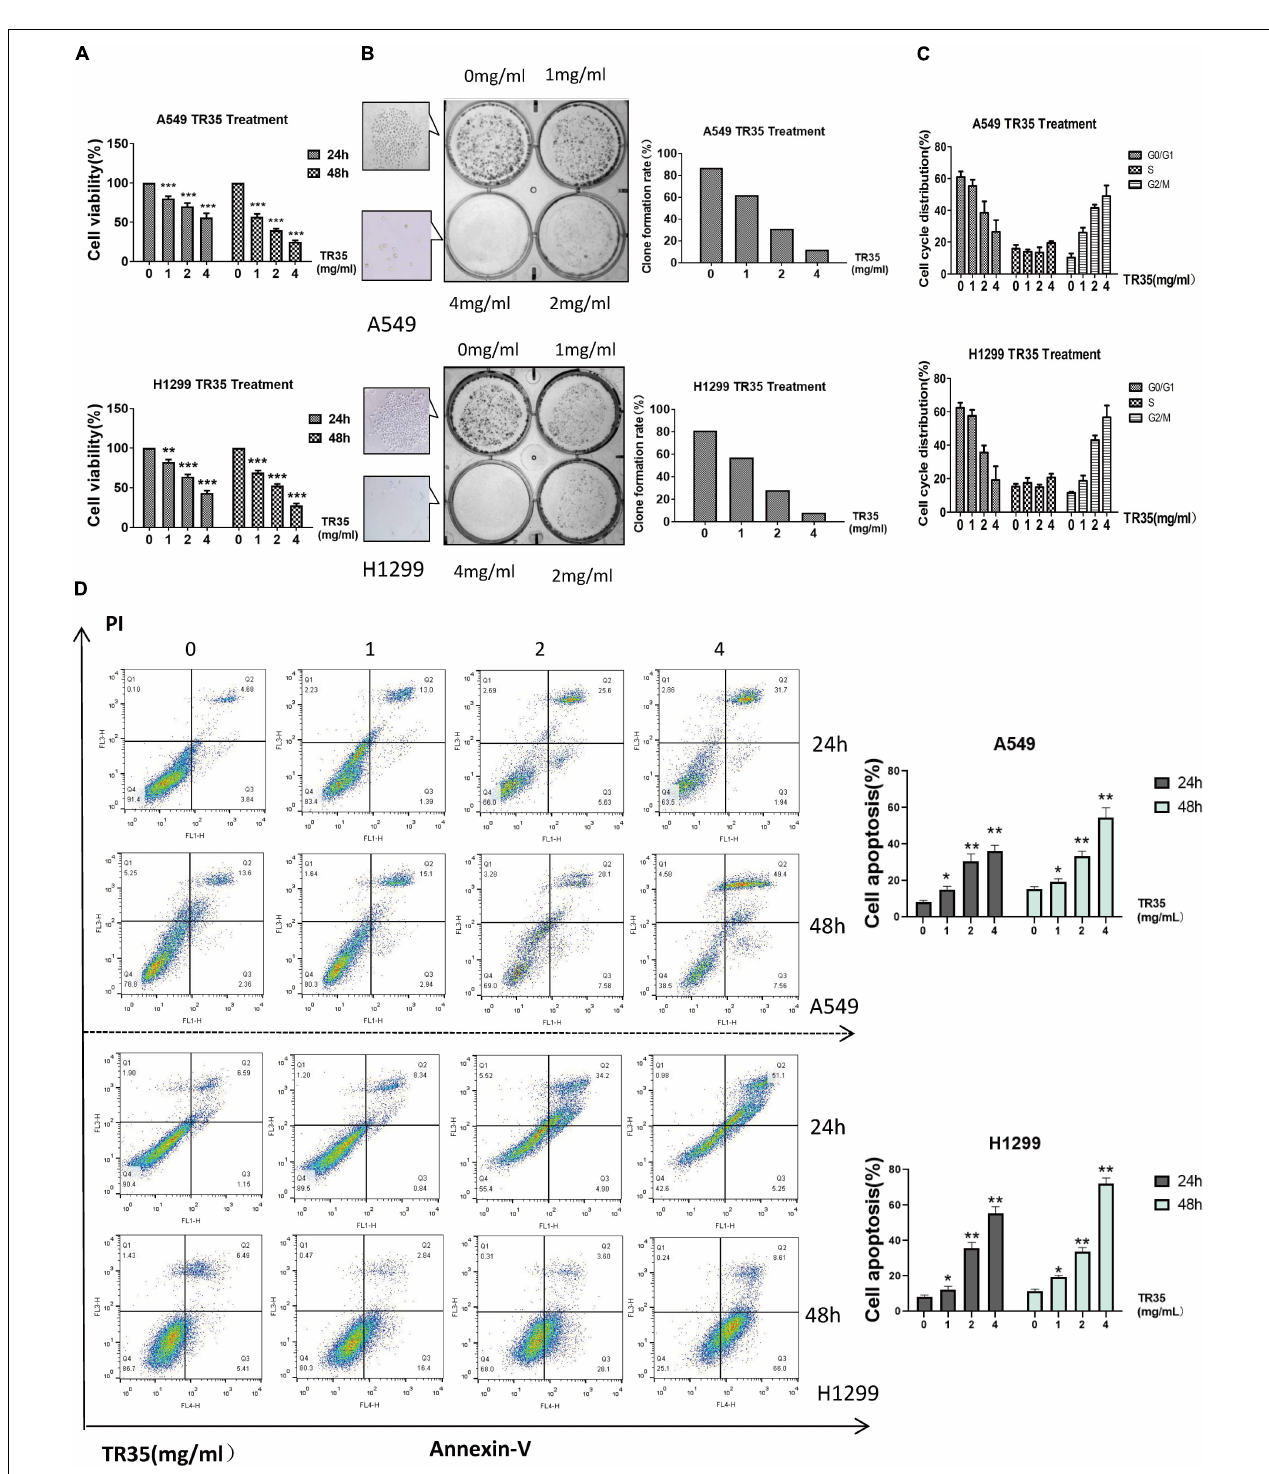
FIGURE 1 | TR35 induced inhibition of A549 and H1299 cell growth. (A) CCK-8 assay evaluation of the inhibition of proliferation of A549 and H1299 cells incubated with TR35 at different concentrations and different times. (B) Colony-formation of A549 and H1299 cells inhibited by TR35. Cells were exposed to different concentrations of TR35 for 11 days in the colony formation assay. (C) TR35-induced G2/M cell cycle arrest. G2/M cell cycle arrest increased in the TR35 treated A549 and H1299 cells. (D) Flow cytometry of Annexin V and PI double staining of A549 and H1299 cells treated with TR35 at different concentrations for 24 and 48 h. Columns show the percentages of apoptotic cancer cells incubated with TR35. The data are representative of three independent experiments. Data are expressed as the mean ± SEM of three determinations (* p < 0.05, ** p < 0.01, *** p < 0.001 vs. CON).